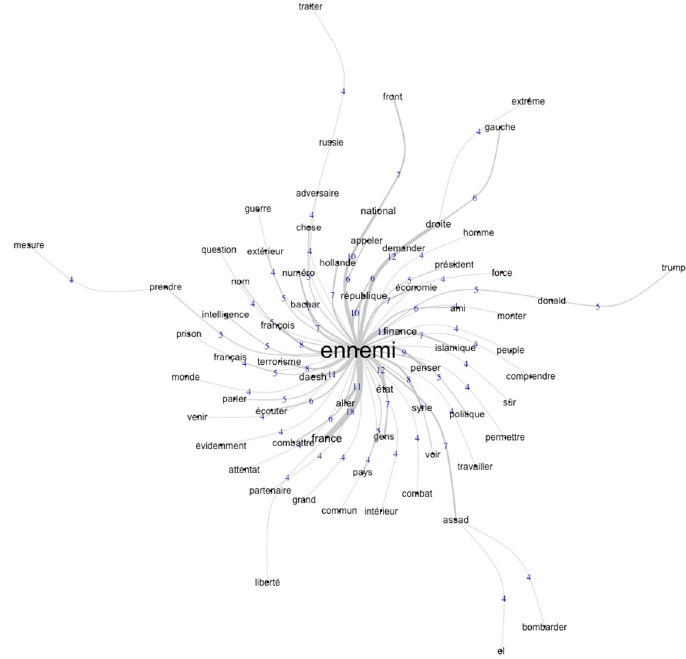
Figure 4. Similarity analysis.